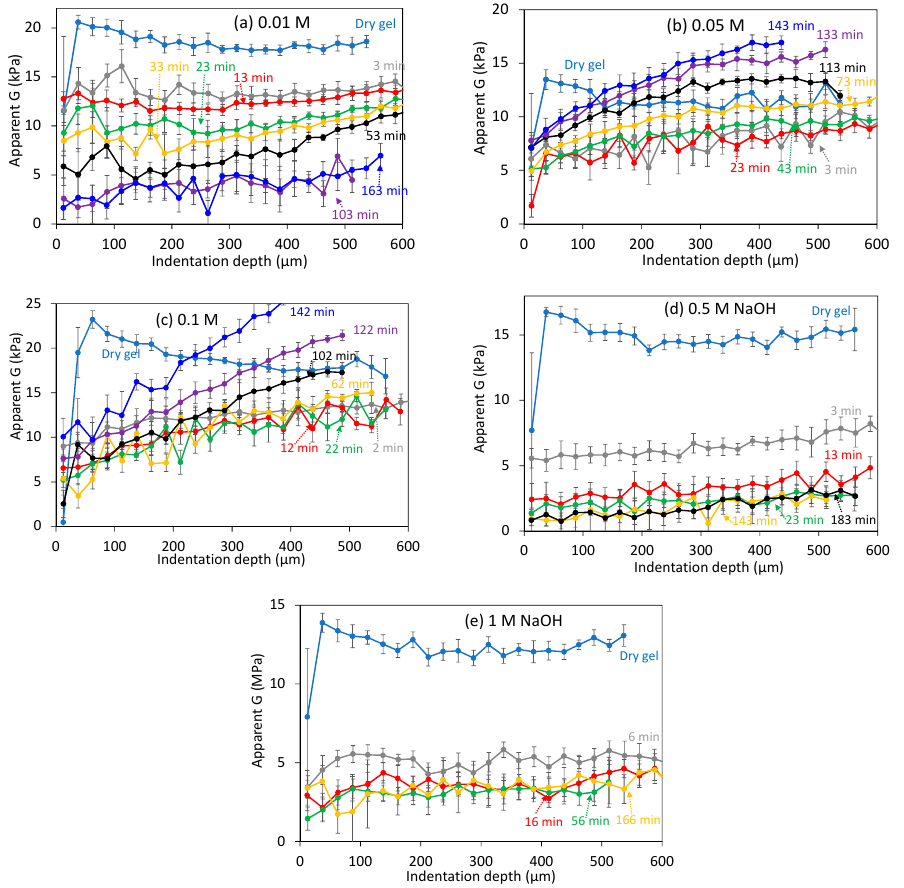
Figure 9. Calculated shear modulus at different indentation depths in (NaOH) typical of dissolution experiments. Note that as Equation (1) is only valid for homogeneous samples, G estimates with depth can only highlight qualitatively if substantial mechanical inhomogeneity occurs in the tested swollen layer. Error bars are as in Figure 4.